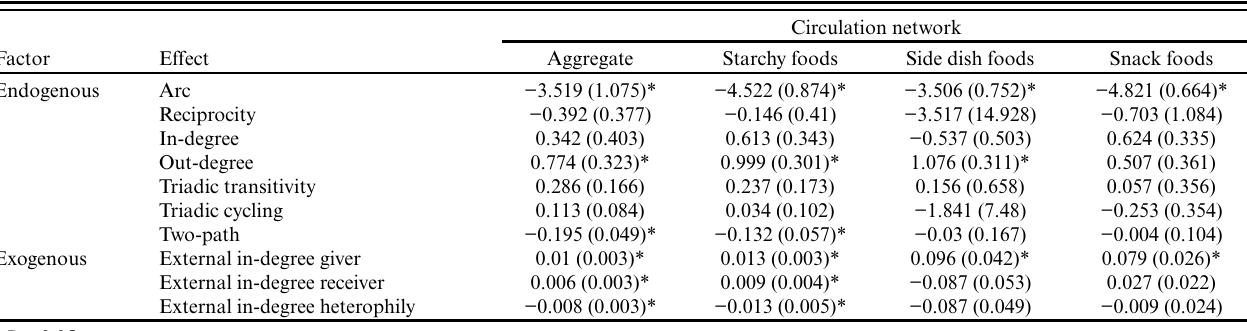
Table 3. Estimations of exponential random graph models (SE) for circulation networks for: all food plants (aggregate), starchy foods, side dish foods, and snack